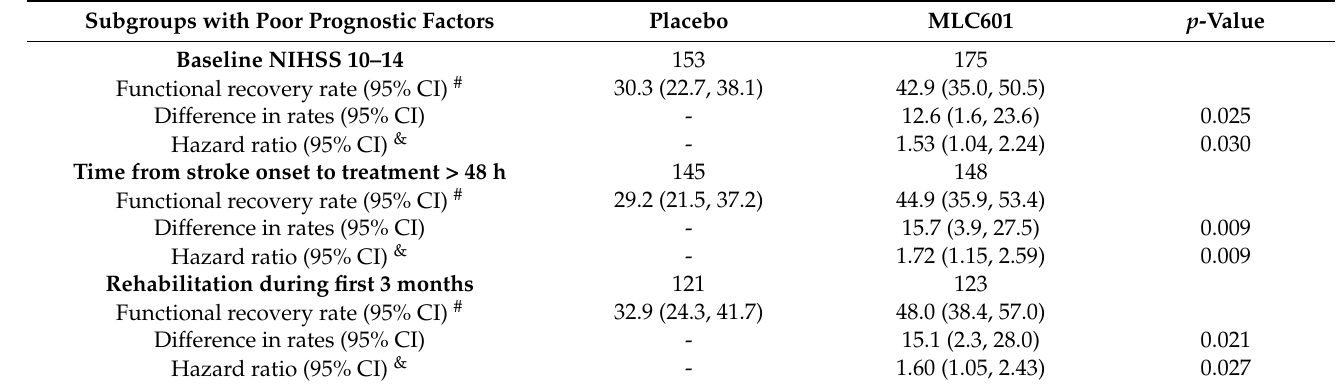
Table 3. Time to achieve functional recovery over 2 years in subgroups with poor prognostic